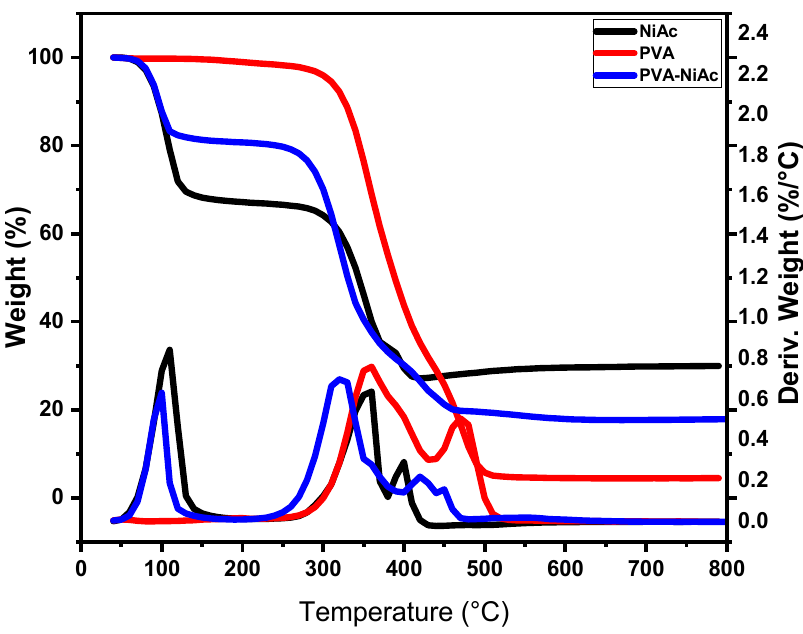
Figure 3. TGA/DTA analysis of NiAc, PVA, and PVA/NiAc blend.